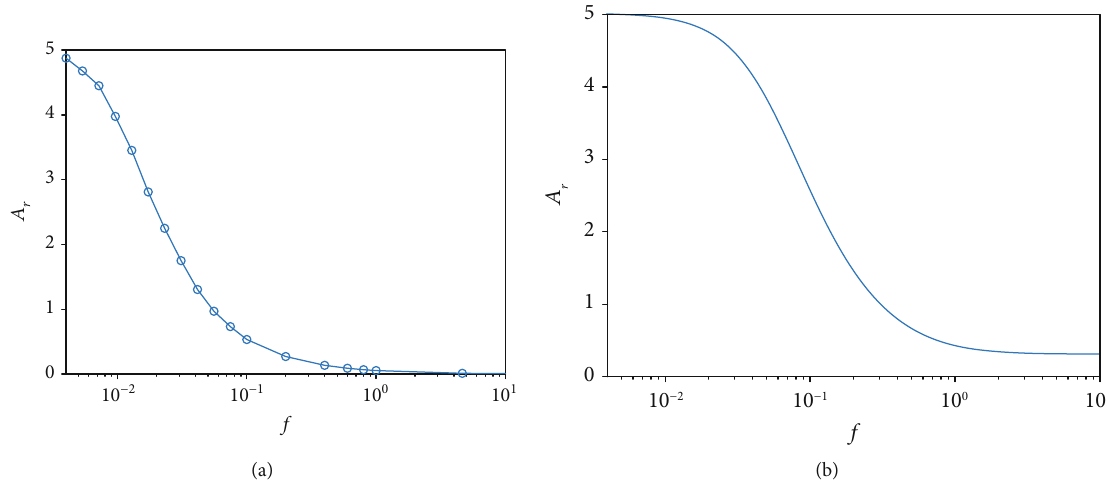
Figure 10: In fl uence of frequency, f ( x -axis), on the amplitude ratio, A j = 0 : 2600 and ϵ = 0 : 1750 . SLS model, at conditions j (cid:1) ρ 0